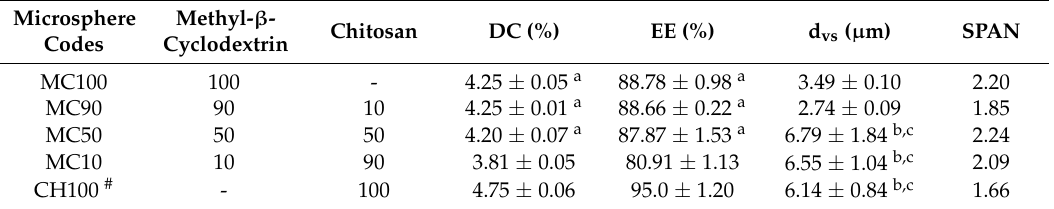
Table 1. The polymer composition (% w / w ), drug content (DC) and encapsulation efficiency (EE) of loaded